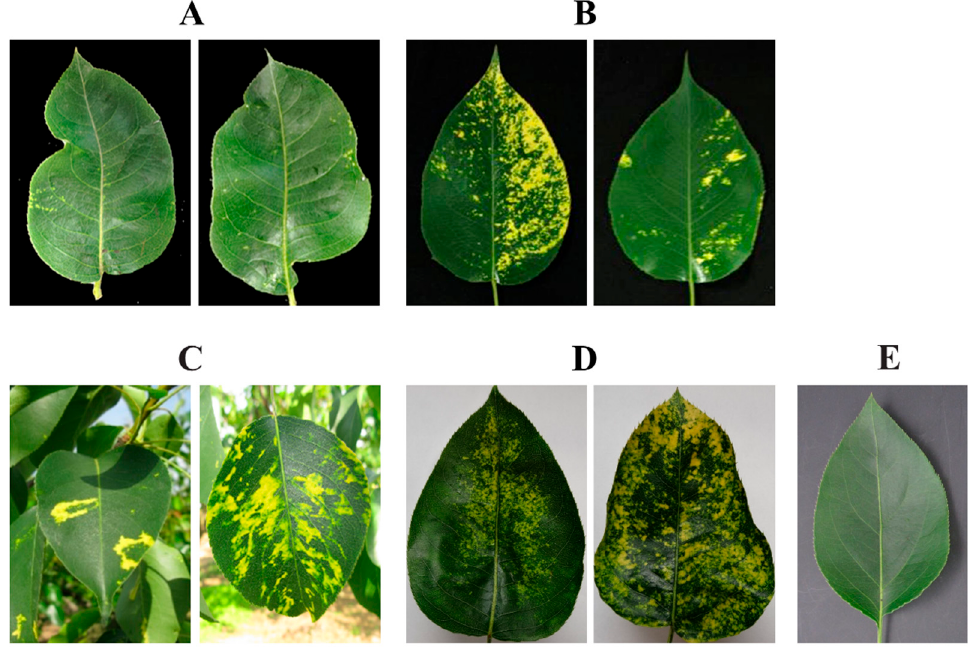
Figure 1. Disease symptoms on pear leaves used for high-throughput sequencing. ( A ) Cuiyu (ID: S17E2), ( B ) Chili (ID: LYC2), ( C ) Xiangshui (ID: LYXS), ( D ) Cuiguan (ID: FJCG), and ( E ) Huanghua (ID: FJHH).